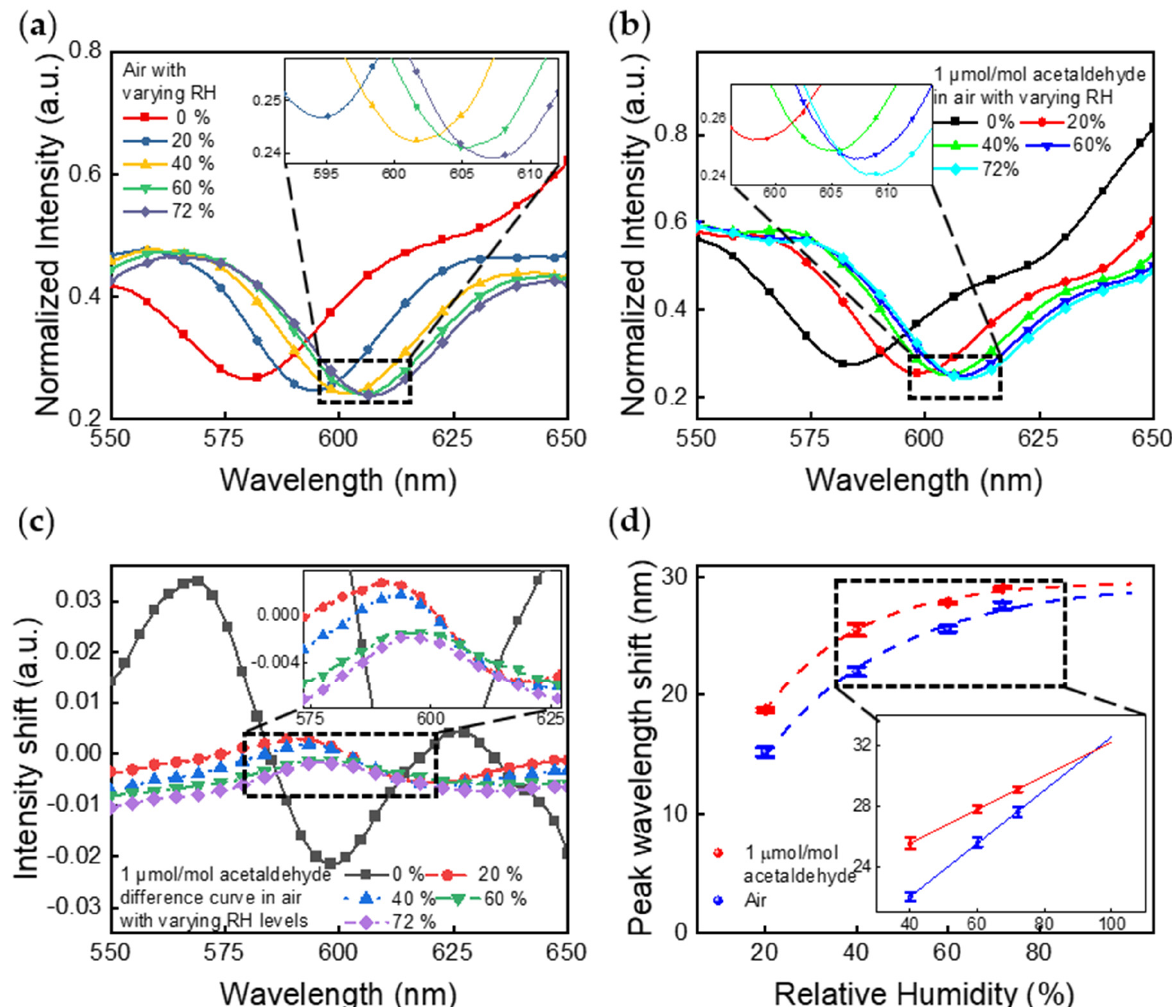
Figure 4. Peak wavelength and intensity shifts of the NHA sensor while the RH varies from 0% to 72% with ( a ) 0 µ mol/mol acetaldehyde and ( b ) 1 µ mol/mol acetaldehyde. ( c ) Responses, shown as difference curves, were obtained by subtracting from the response spectrum of the NHA to 1 µ mol/mol of acetaldehyde in air (at each RH level), the response spectrum of 0 µ mol/mol of acetaldehyde in air at the corresponding RH levels. ( d ) Summary of peak wavelength shifts vs. RH levels of each condition in ( a , b ). For high RH levels ( ≥ 40%), the sensor shows linear responses vs. RH levels. The estimated upper RH limit for detecting 1 µmol/mol acetaldehyde is about 95% RH based on the linear curve fitting with 95% confidence interval. The error bars represent ± 1 standard deviation for measurement results captured from 4 different testing trials on 2 sensors.